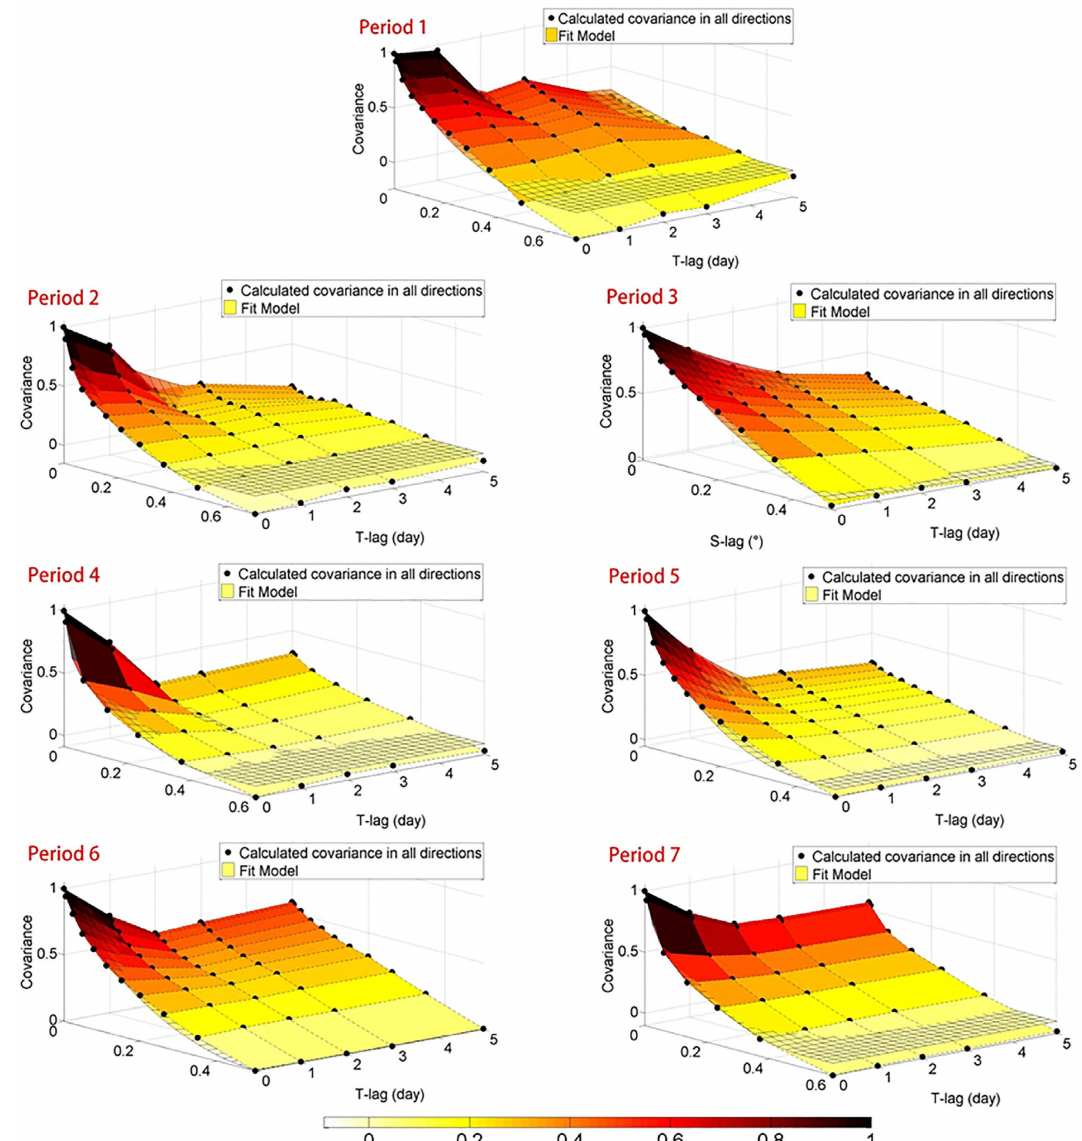
Figure 5. The calculated covariance in all directions and the corresponding fit models for different periods (from period 1 to